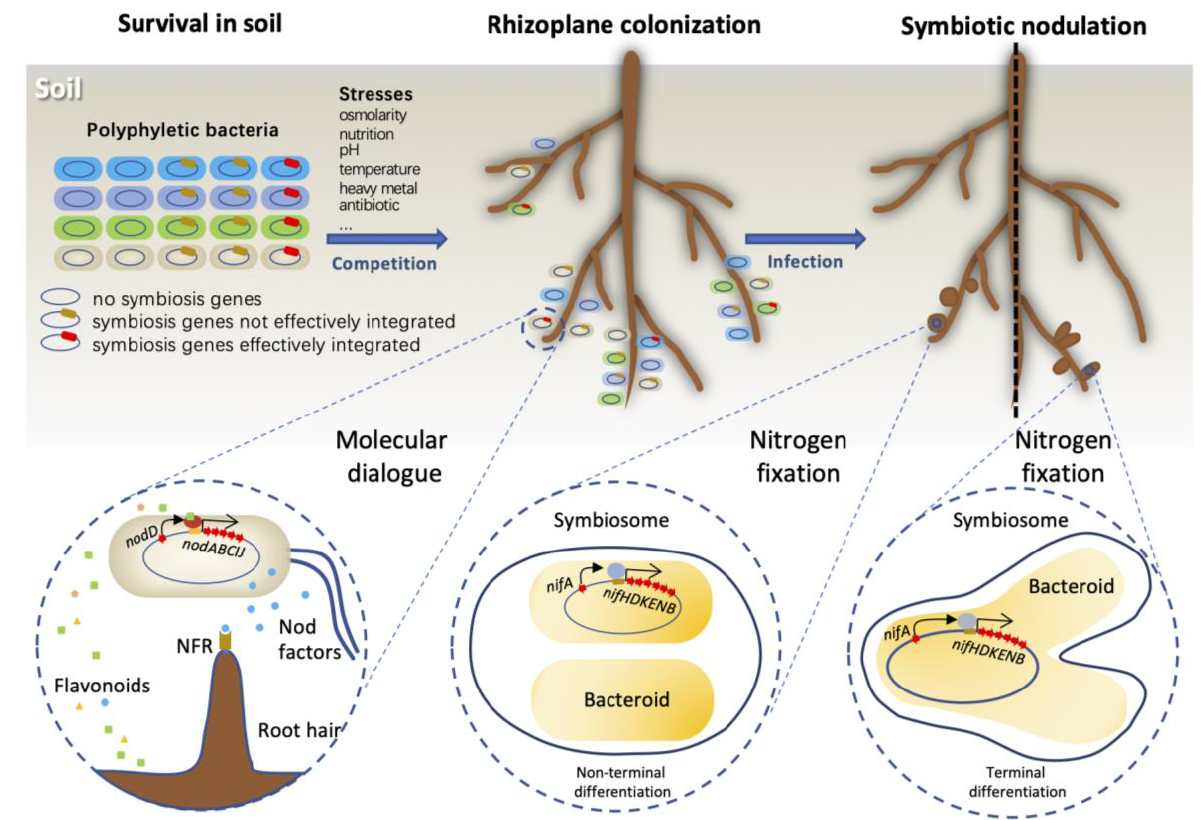
Figure 1. Adaptive evolution of rhizobium symbiosis. After acquiring the key symbiosis genes ( nod and nif ) by horizontal gene transfer (HGT), bacteria recipients confront ever-fluctuating environmen- tal conditions and resources, and interactions with other soil microorganisms and plants. During the process of adaptive evolution, those bacteria, with the key symbiosis genes effectively integrated with the genomic background, survive the saprophytic life, colonize the host rhizoplane, communicate and establish a mutualistic symbiosis relationship with the host plant. In a strain–host-dependent manner, the nitrogen-fixing rhizobia, named bacteroids, are at either non-terminal or terminal differentiation status within symbiosome. nod , nodulation; nif , nitrogen fixation; NFR, nodulation factor